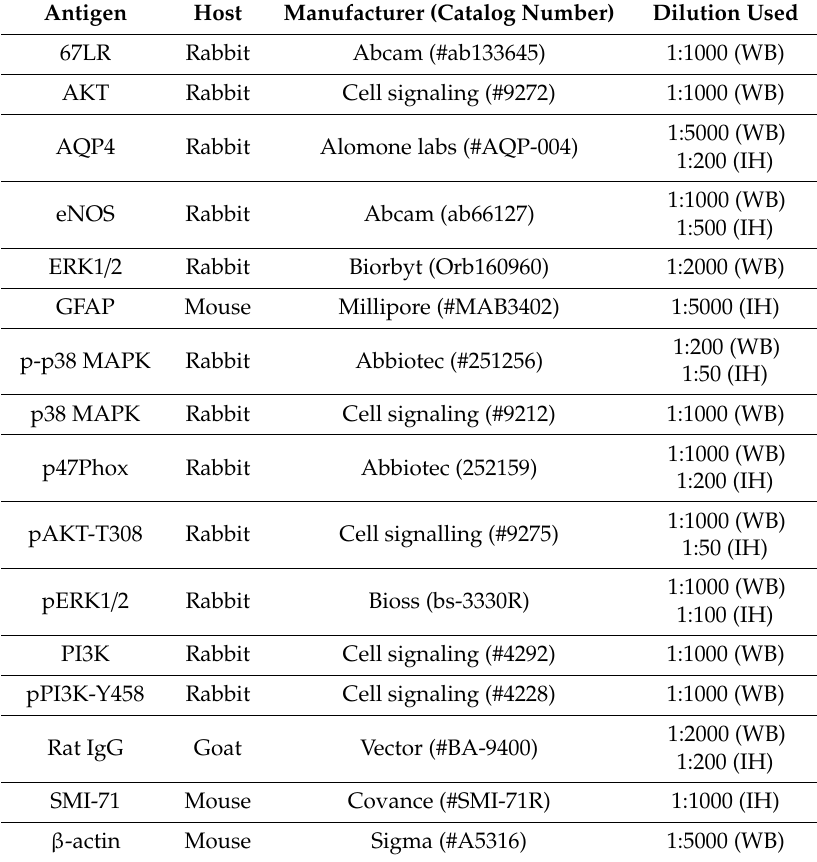
Table 1. Primary antibodies and lectin used in the present